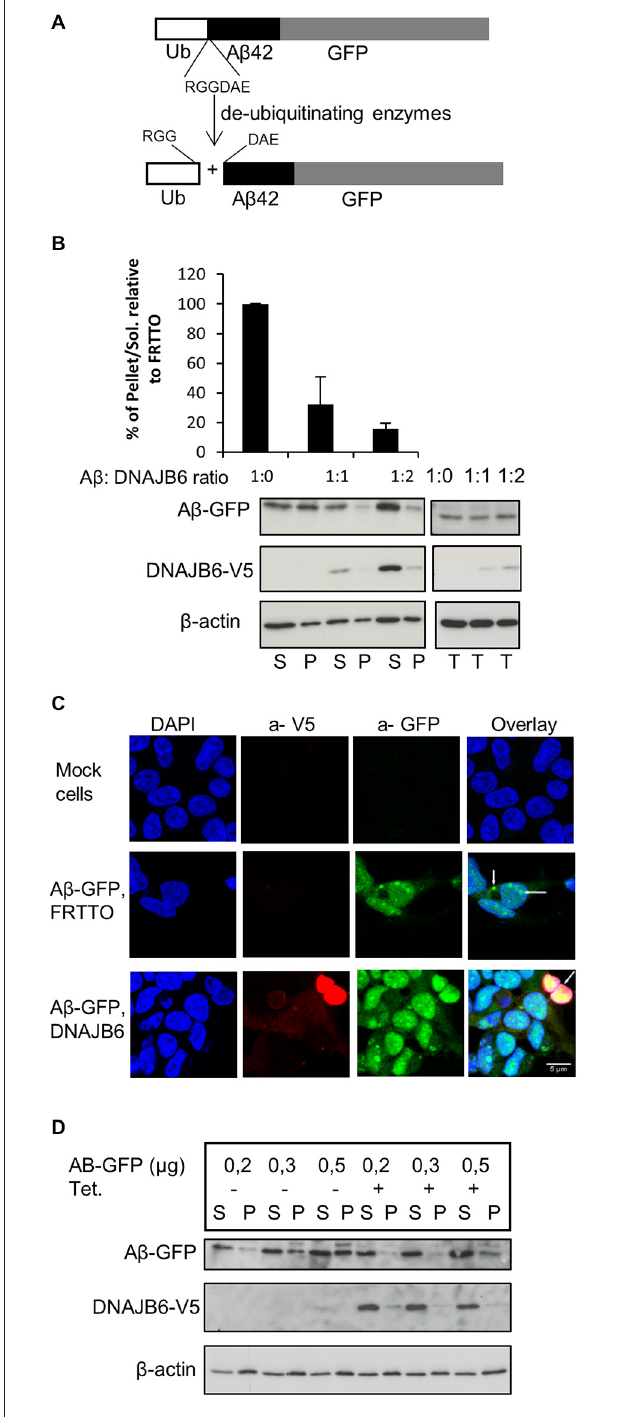
FIGURE 1 | DNAJB6 prevents the aggregation of A β 42-GFP. (A) Scheme of generation of A β 42-GFP intracellularly. Cells were transfected with Ub-A β 42-GFP. Upon expression, Ub-A β 42-GFP is cleaved by endogenous ubiqutin C-terminal hydrolases after the RGG amino acid sequence to give rise to Ub and A β 42-GFP at 1:1 ratio. (B) HEK293 cells were transfected with 0.5 µ g Ub-A β 42-GFP with FRTTO-DNAJB6b-V5 at 1:1, 1:2 ratio or FRTTO as a control (1:0 ratio). After 48 h, cells were lysed and separated into Triton X100 ( Continued